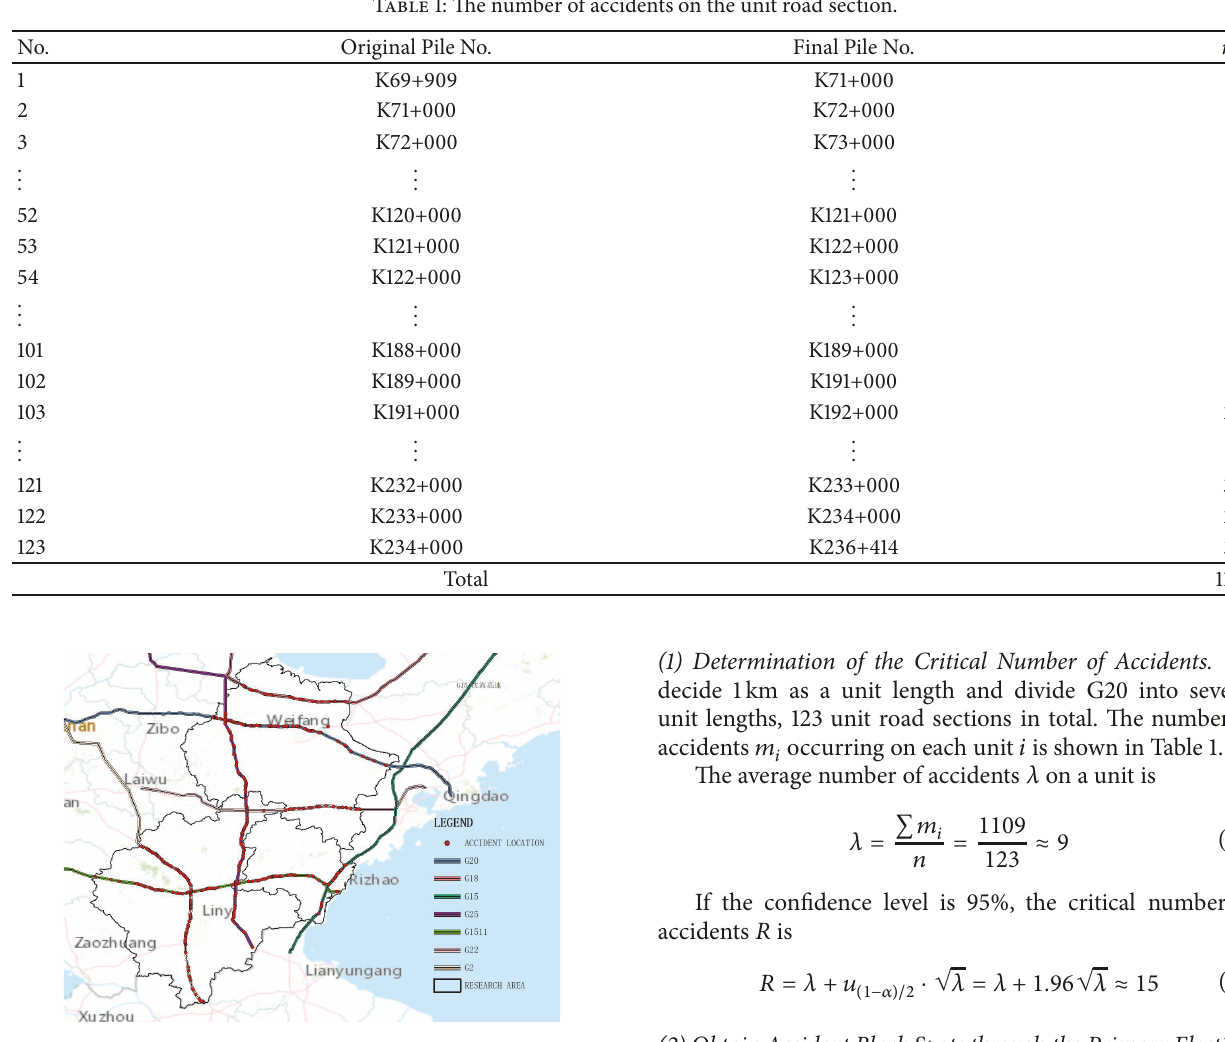
Figure 2: Accident locations marked on the map of ArcGIS.